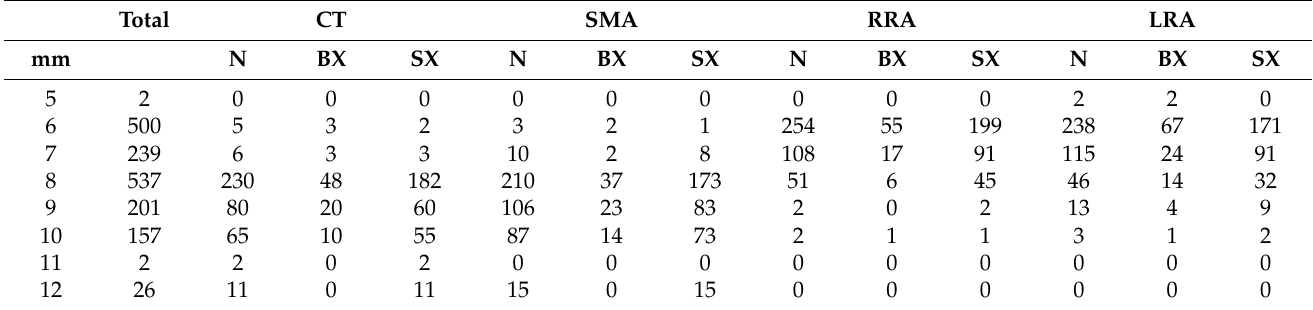
Table 3. This table shows the diameters of bridging covered stents that were used. BX: balloon expandable; SX: self-expanding; CT: coeliac trunk; SMA: superior mesenteric artery; RRA: right renal artery; LRA: left renal artery.